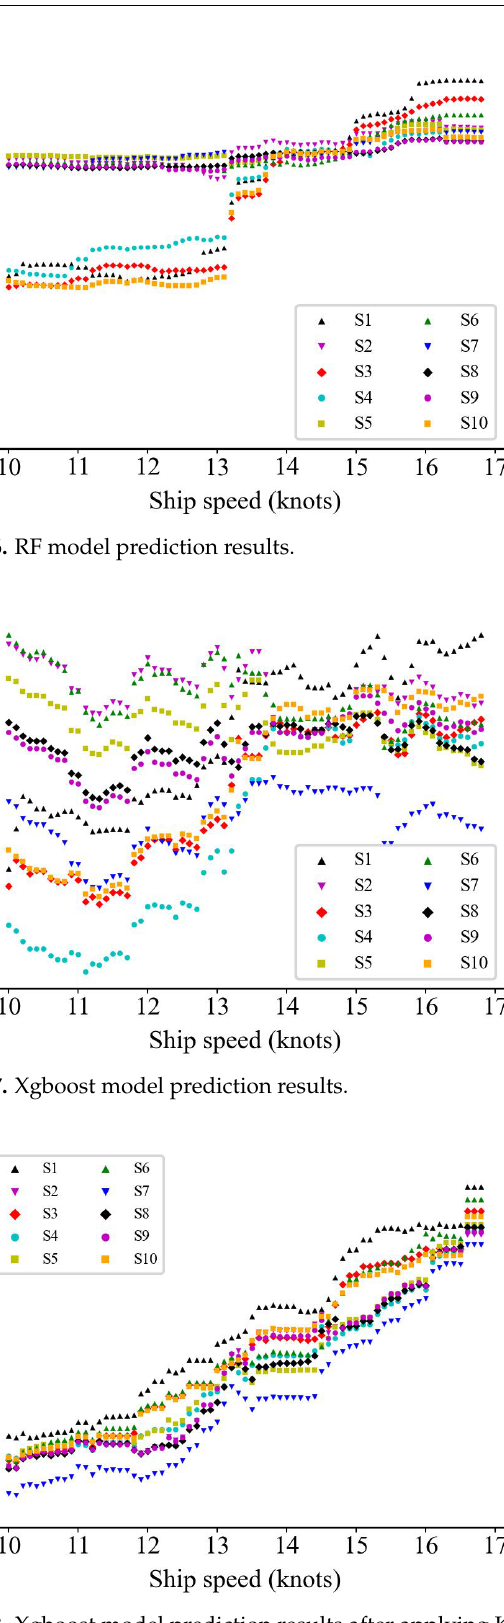
Figure 18. Xgboost model prediction results after applying Kwon cleaning